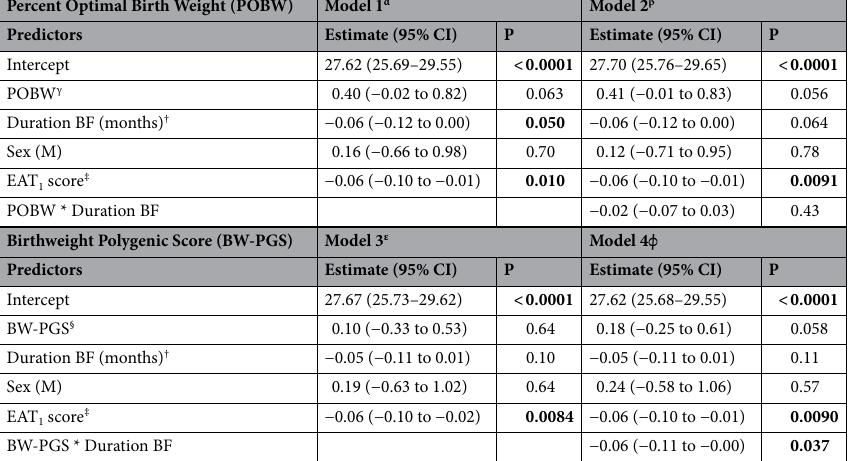
Model 4 examines the ϕ